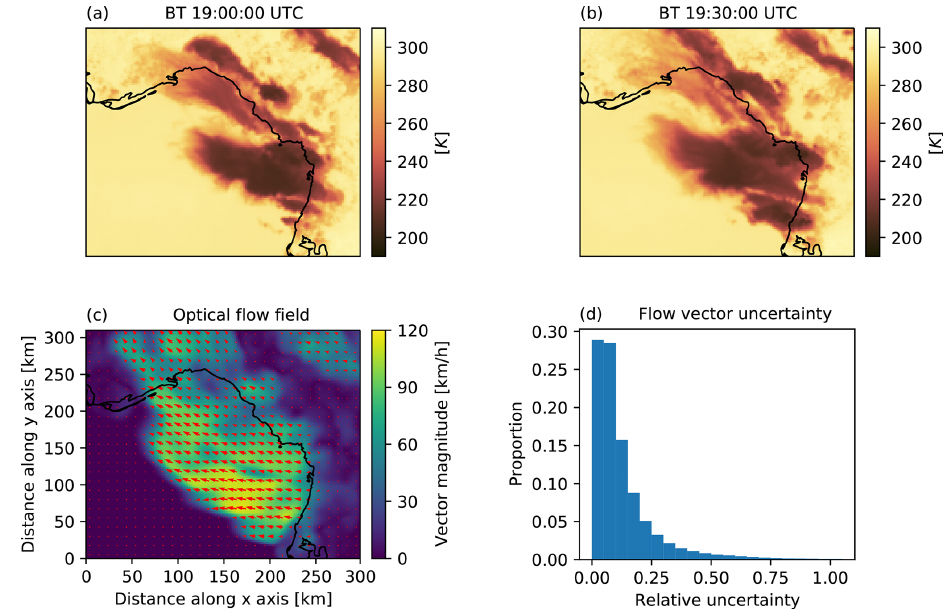
Figure 4. Cloud motion field for the DCC observed in Fig. 1 calculated using optical flow over a 30min period. (a) The initial image and (b) the final image. (c) The calculated optical flow vector field, with the detected motion displayed by the red arrows and the velocity of the vectors by the background. Optical flow vectors are estimated across the entire domain, but are here only visible for the region of high anvil cloud. (d) The relative uncertainty distribution of calculated optical flow vectors.